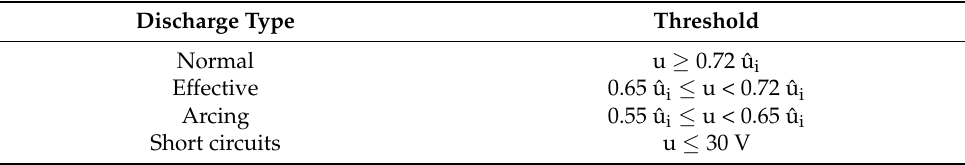
Table 3. Thresholds for discharge types based on Nirala and Saha